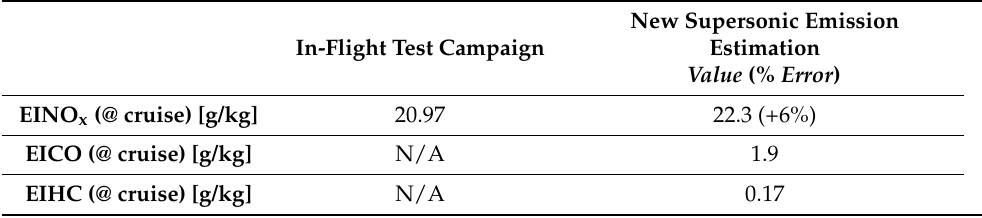
Table 5. Olympus engine emissions in cruise.